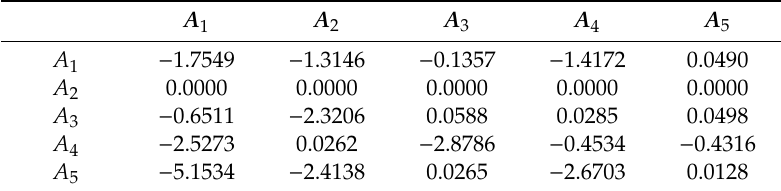
Table 16. Relative prospect dominance ϕ 2 .